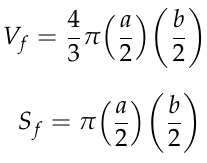
Figure 11. Schematic illustration of the structural change of the self-healing coating with dispersed spherical and fi brous capsules (SHC-SFC) during aging. ( a ) Just after coating the mixture of prepol- ymer/ethylene glycol/spherical and fi brous capsules/cyclohexanone. ( b ) During aging, reaction of prepolymer with ethylene glycol and evaporation of cyclohexanone. ( c ) In the last stage of aging, the formation of polyurethane and fi lm thinning, leading to an increase in capsule density as well as fi brous capsule being aligned parallel to the specimen surface. As described in Section 3.1, the f value of the fi brous capsule is approximately 0.6– 0.9. Namely, the ratio of the long diameter, a , to the short diameter, b , can be calculated to be 2.5:1 for f = 0.6 and 10:1 for f = 0.9. Assuming that the cross-section of the fi brous capsule is a circle, the volume V f is given by Equation (12) and its projected area S f is given by Equation (13).